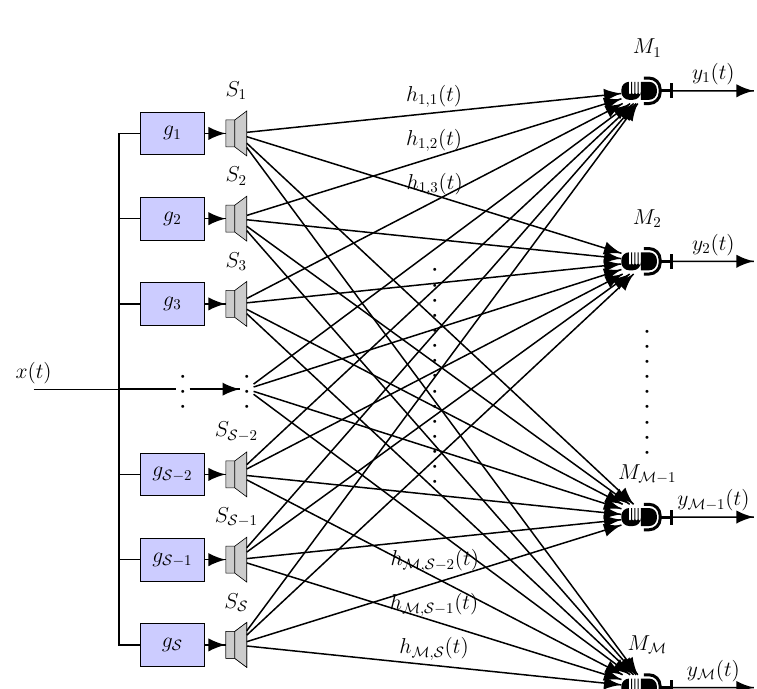
Figure 1. Multi-point equalization problem: with microhones. The equalizing filters g s are designed to invert the environment impulse M responses h m , s